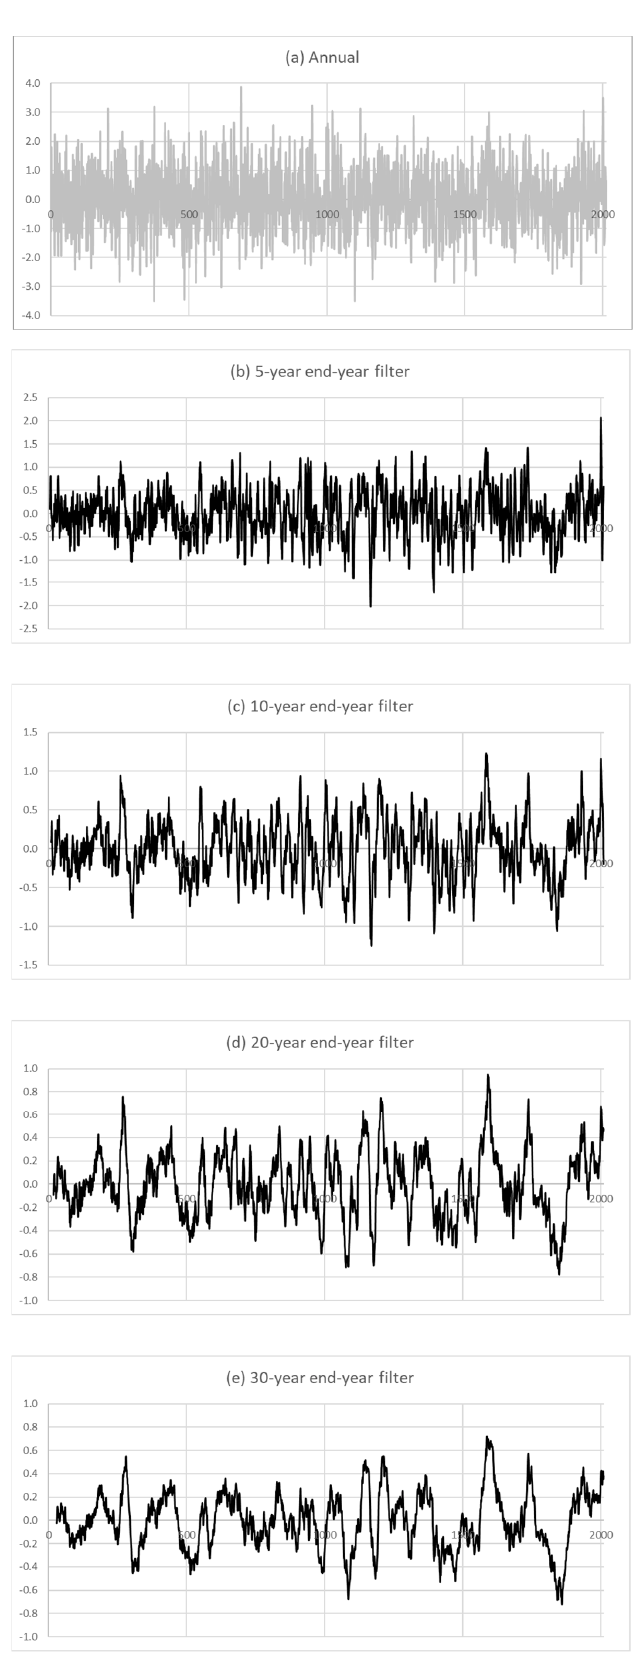
Figure 9. Reconstructed regional streamflow standardized from 0 to 2012 AD for ( a ) Annual, ( b )